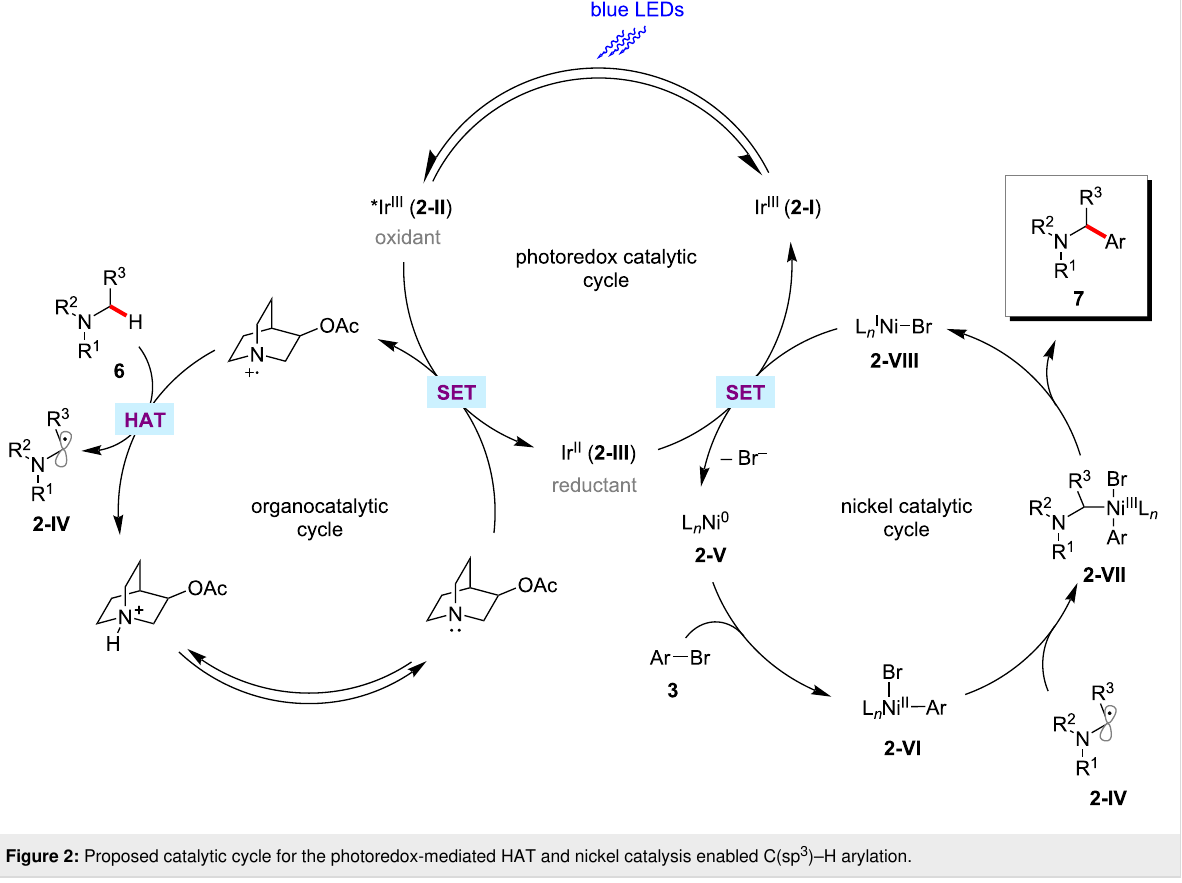
Figure 2: Proposed catalytic cycle for the photoredox-mediated HAT and nickel catalysis enabled C(sp 3 ) ‒ H arylation.